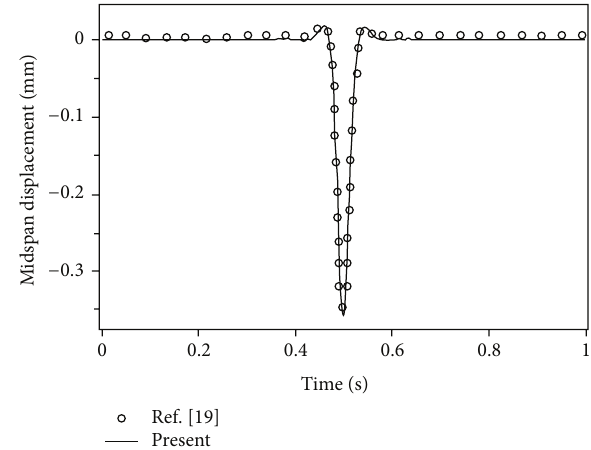
Figure 2: Comparison of the displacement response with [19].